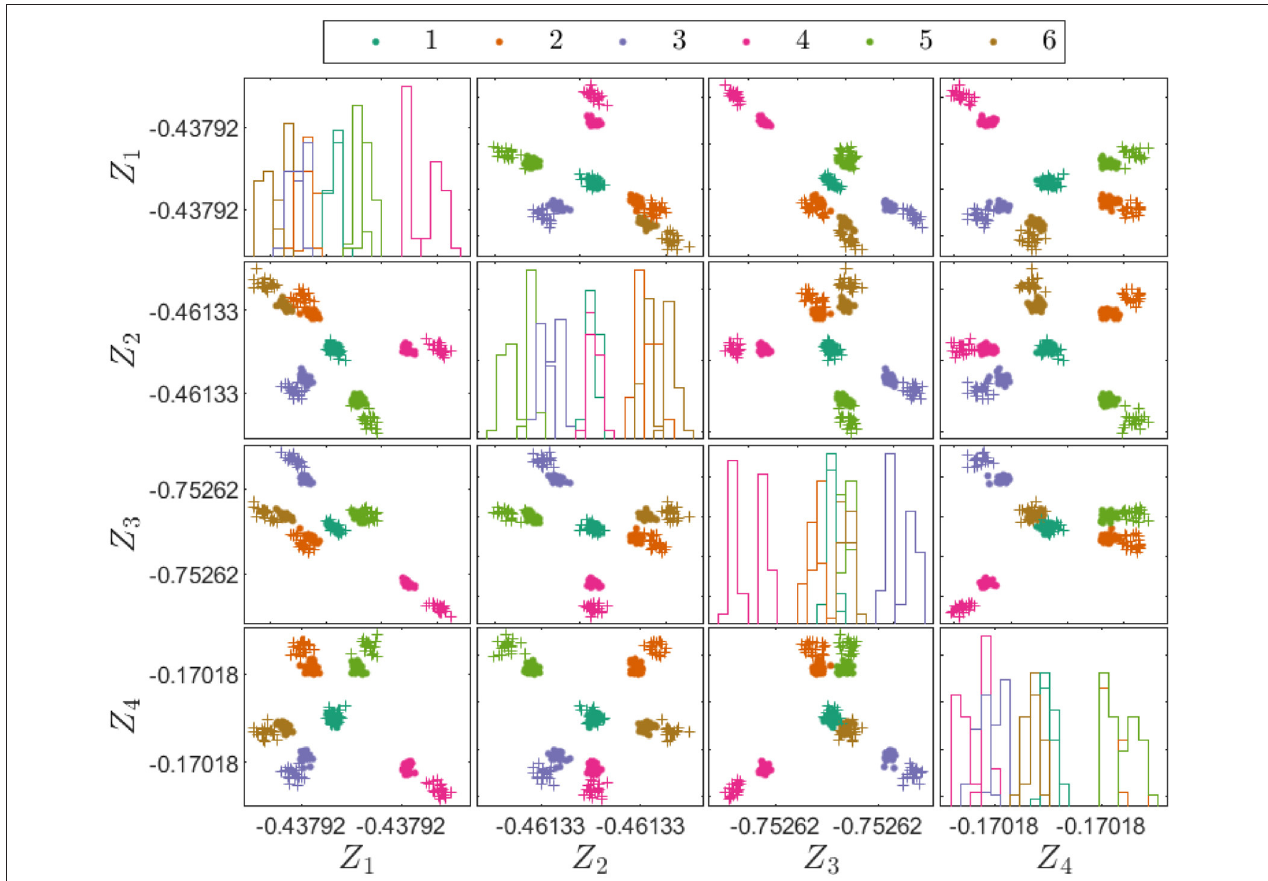
FIGURE 7 | Transfer components for the source and target domains in the heterogeneous population case study with geometric and material differences. The source domain transfer components are denoted by dot markers, the target-domain training and testing transfer components are denoted by cross-markers and circle markets